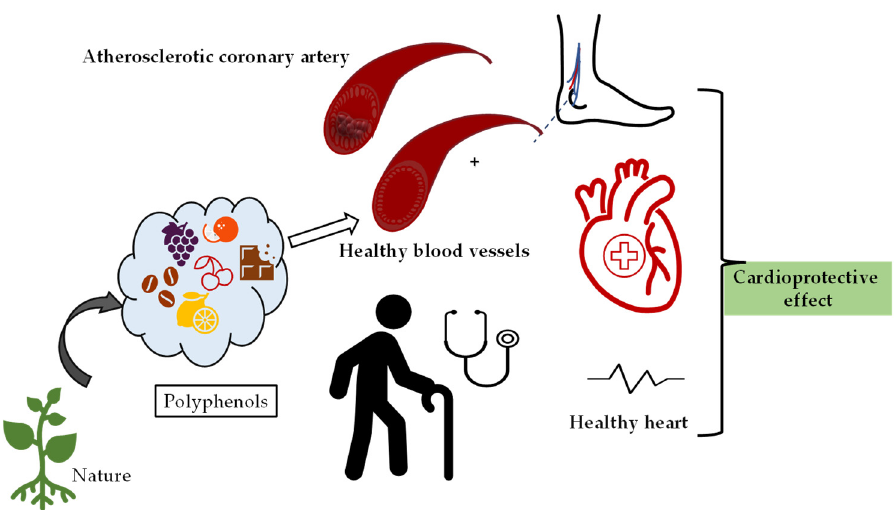
Figure 3. Demonstration of the protective effects of natural products containing polyphenolics on cardiovascular system